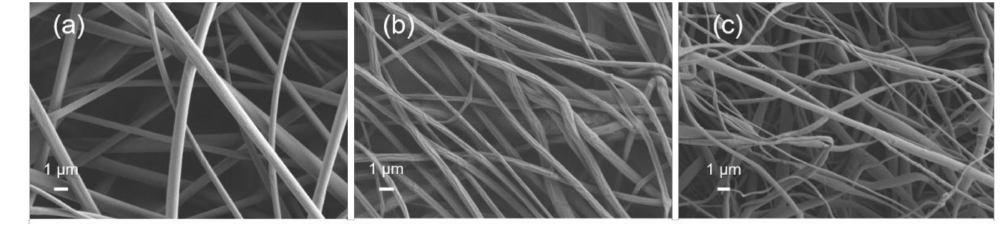
Figure 1. Electrospun fibres ( a ) CA, ( b ) PLLA, ( c )